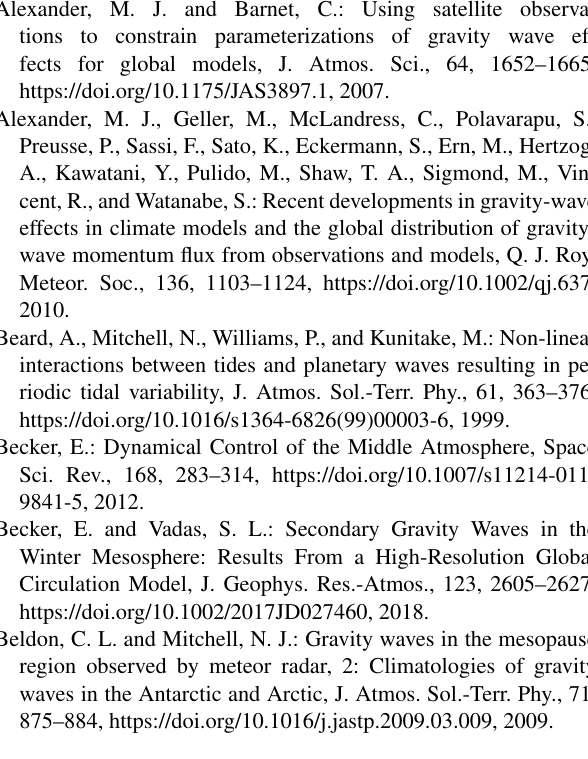
figurations, J. Geophys. Res.-Atmos., 127,